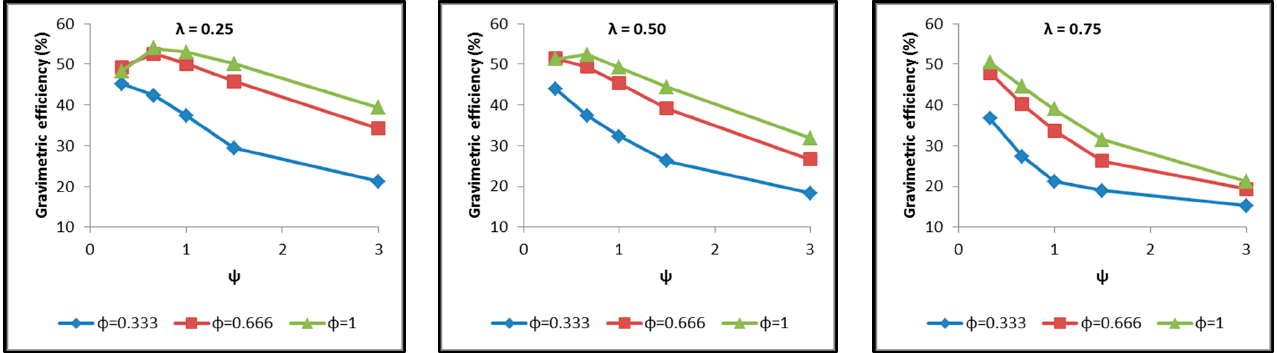
Figure 22. Distribution of the tank gravimetric efficiency as a function of the ratios λ , φ and ψ .